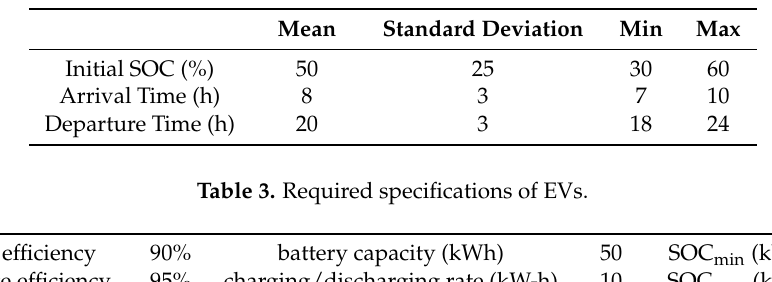
Table 2. Probability distribution of EVs. Table 6. The profit of different DR programs in β = 0, 1.